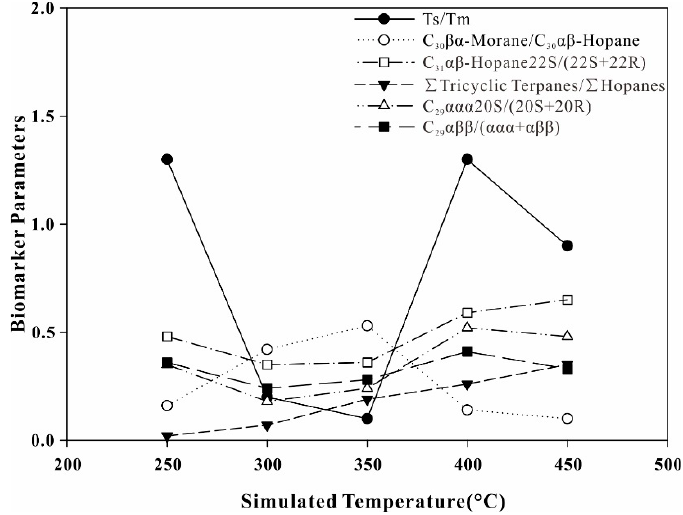
Figure 5. The biomarker parameters of different simulation